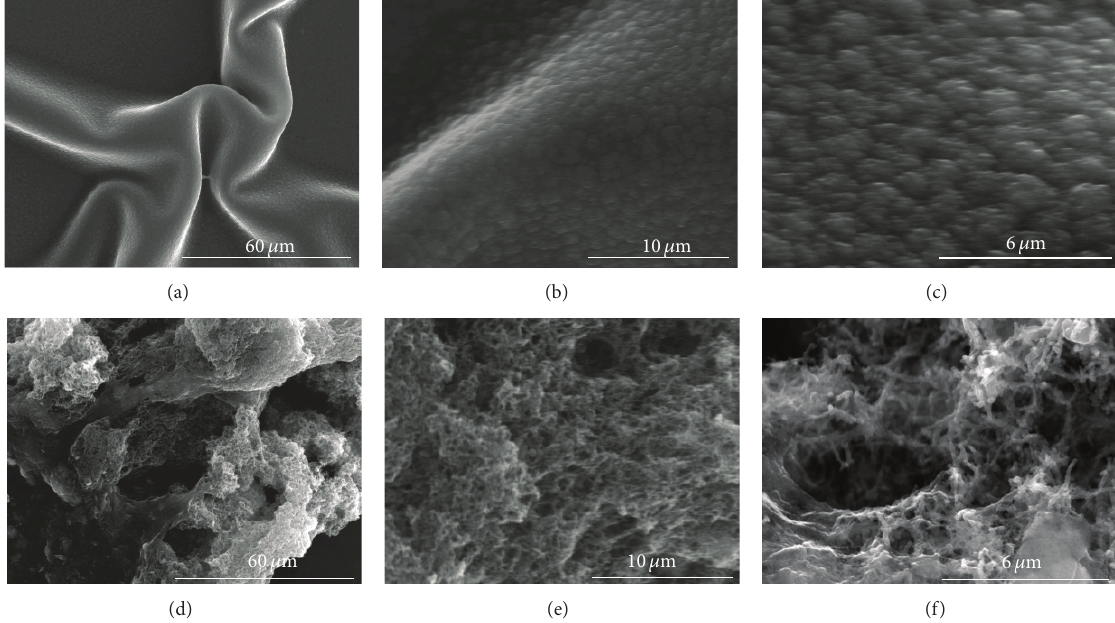
Figure 2: SEM morphology for PPY ((a)–(c)) and PPY/CNTs composite films ((d)–(f)) obtained galvanostatically at 0.1mAcm −2 for 20min.